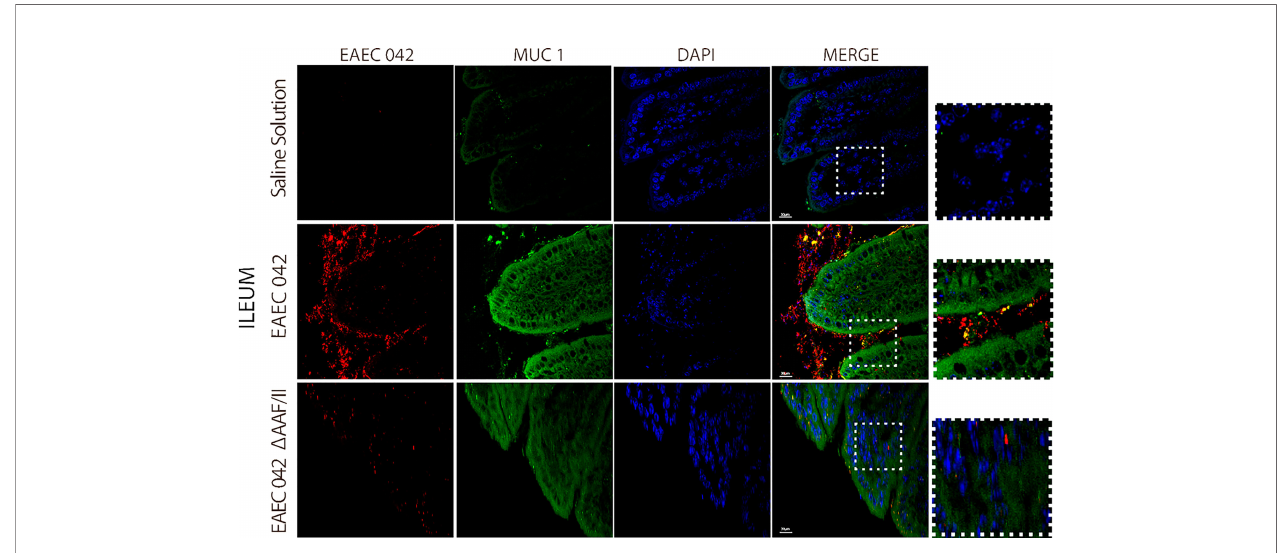
FIGURE 8 | Immuno fl uorescence of MUC1 on ileum at 4 days post-infection. MUC1 was stained with a secondary antibody conjugated with Alexa 480 antibody (green), bacteria with a primary antibody against EAEC 042 AAF/II and as secondary antibody Alexa 568 (red), and nucleic acids with DAPI